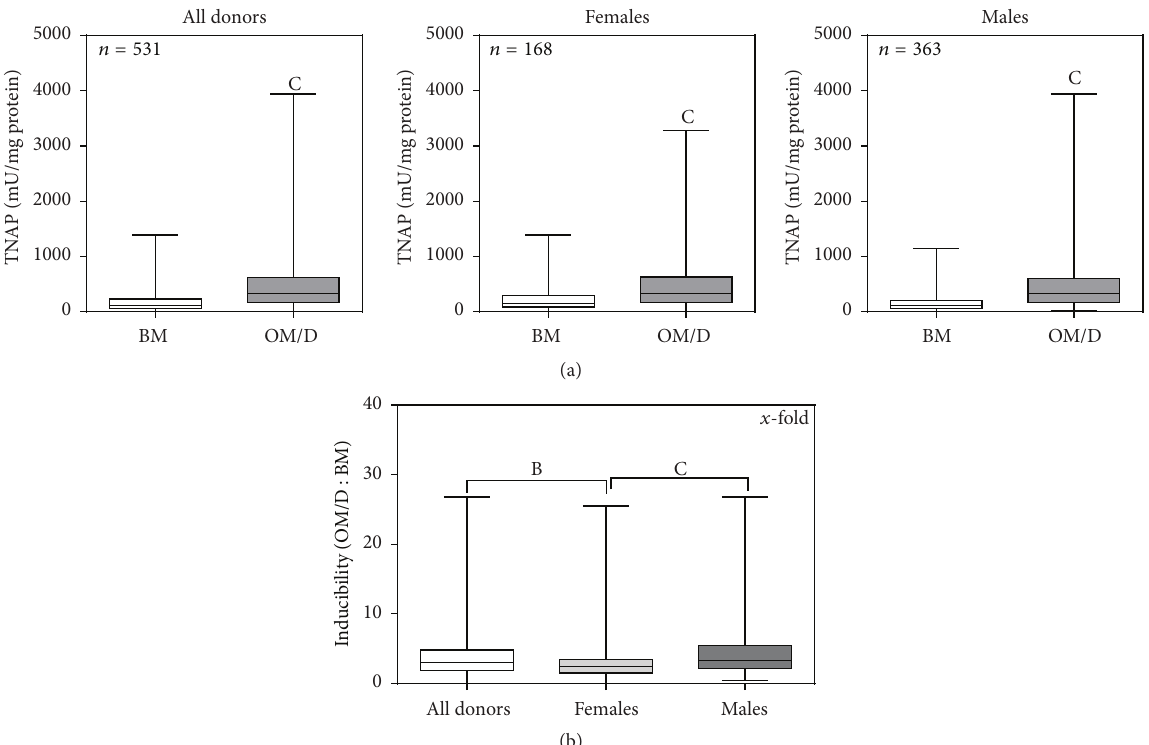
Figure 1: Osteogenic differentiation potential of hBMSC (TNAP activity and TNAP inducibility). hBMSC in passage 1 were plated in BM (basic medium) onto TCPS (= P2). From day 4 after plating, the cells were cultured either in BM or in OM/D (osteogenic differentiation medium) and analyzed at day 15 after plating for TNAP activity with p-nitrophenylphosphate as a substrate; the calculation of TNAP activity was performed with a linear calibration curve obtained with p-nitrophenolate ( 𝑟 = 0.9979 ). (a) TNAP activity was normalized to the protein content of the lysates and plotted for all donors and female and male donors, separately. Significant differences of OM/D mean versus BM mean values were analyzed by paired 𝑡 -test and indicated with C ( 𝑝 < 0.001 ); 𝑛 = 531 (all donors), 𝑛 = 168 (females), and 𝑛 = 363 (males). (b) The inducibility of TNAP activity (TNAP activity in OM/D: TNAP activity in BM) was calculated from individual donor data pairs and presentedforalldonors,femalesandmalesaswell.Significantdifferencesofmeanvalueswereanalyzedbyone-wayANOVAwithBonferroni’s post-test and indicated with B ( 𝑝 < 0.01 ) and C ( 𝑝 < 0.001 ); 𝑛 = 531 (all donors), 𝑛 = 168 (females), and 𝑛 = 363